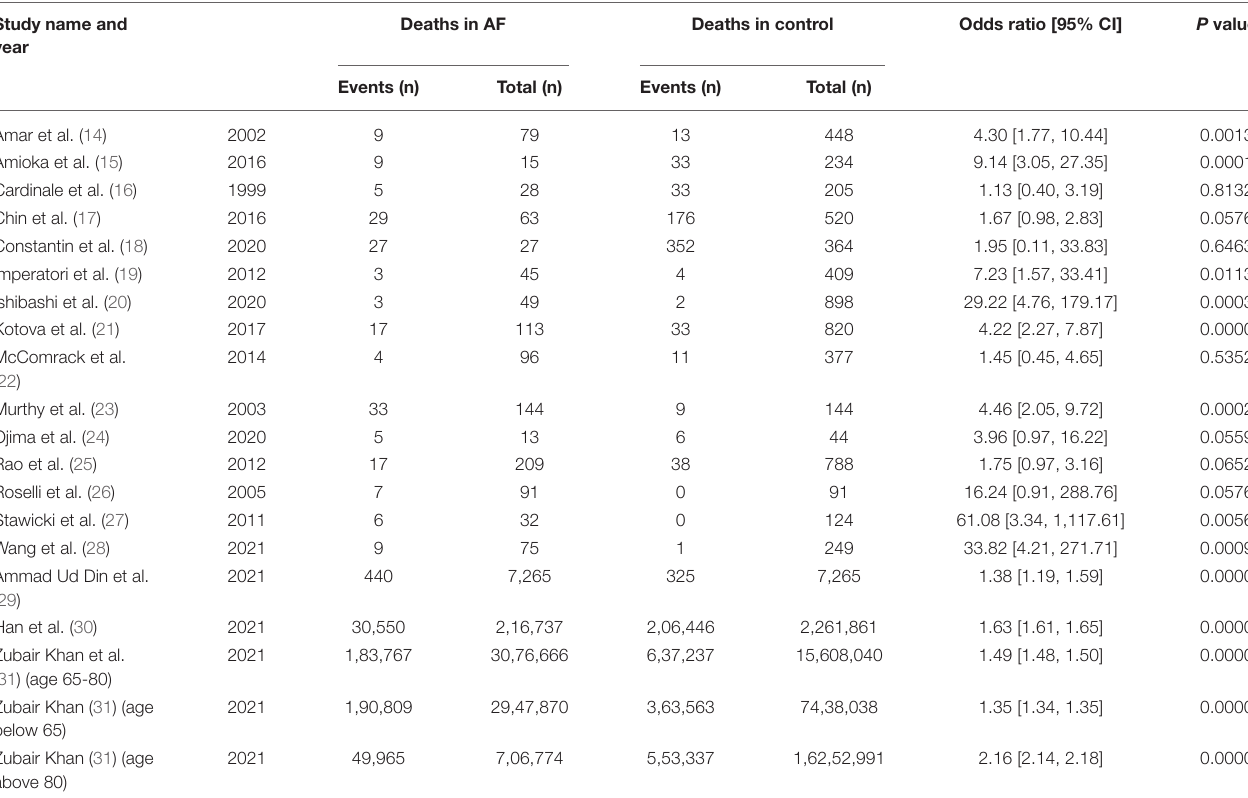
TABLE 5 | Analytical details of the studies that were